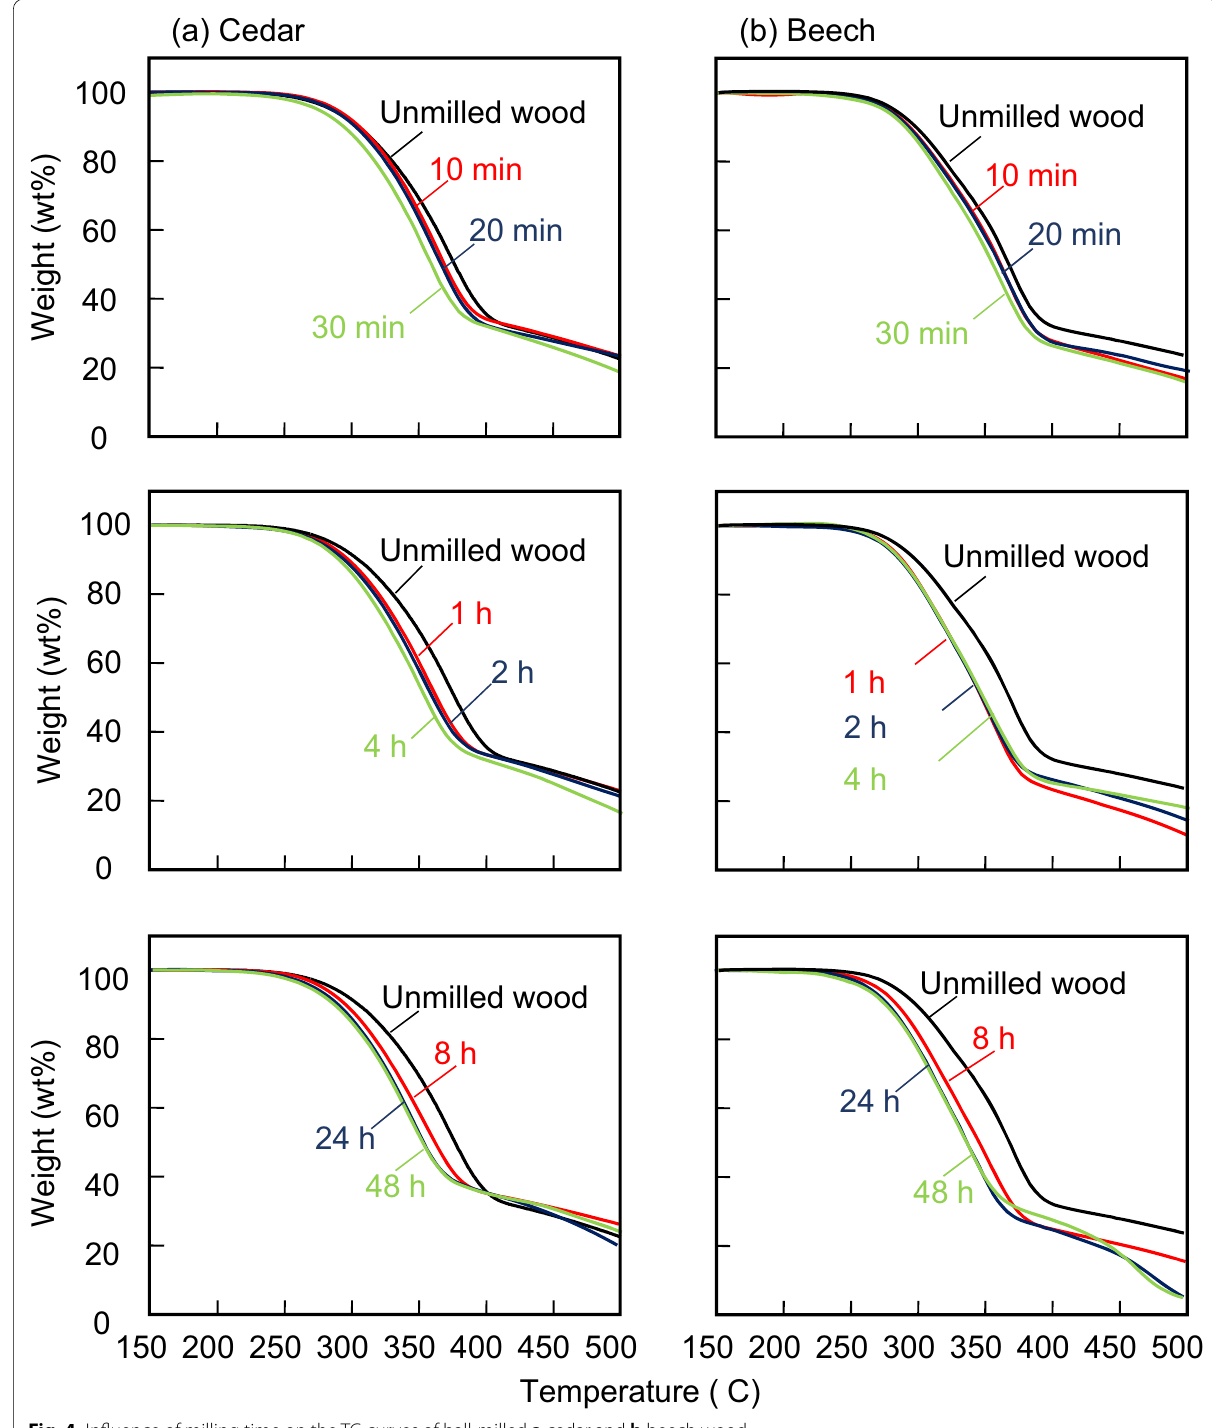
Fig. 4 Influence of milling time on the TG curves of ball-milled a cedar and b beech